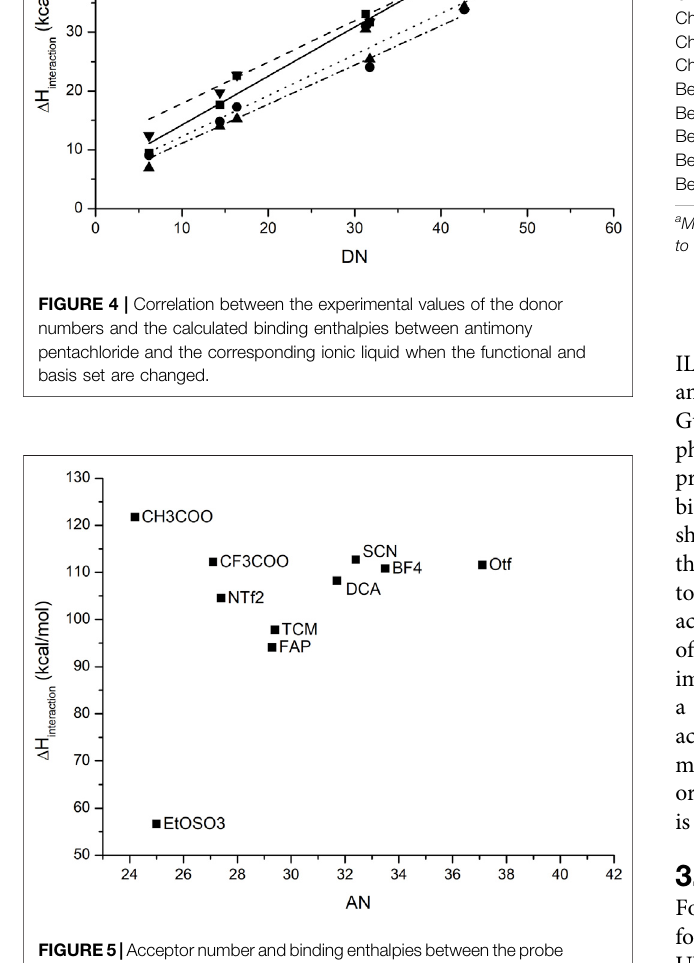
FIGURE5| Acceptornumberandbindingenthalpiesbetweentheprobe and the IL. The lack of a discernible trend prevents us from considering successful this methodology of calculation.